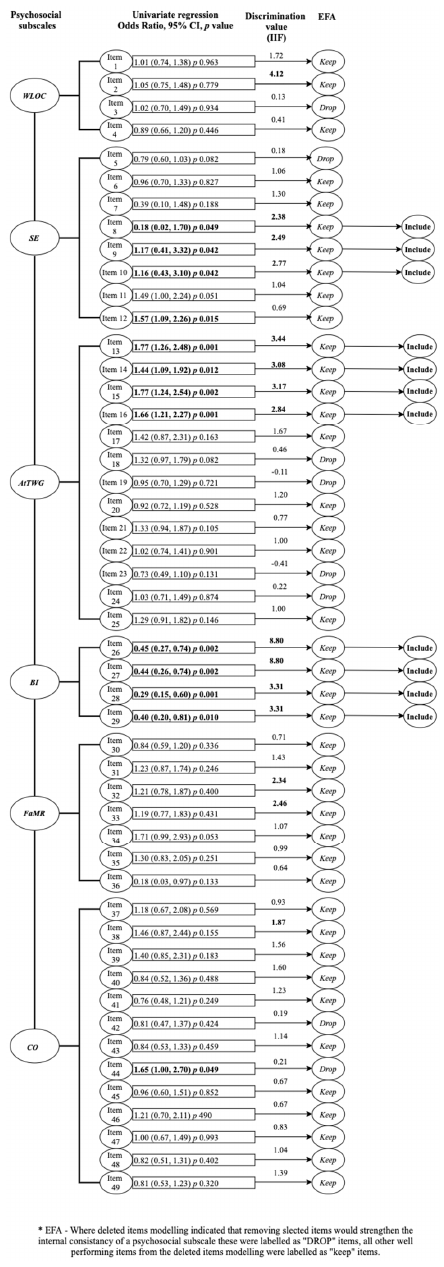
Figure 2. Full model of results from the scale reduction analysis.